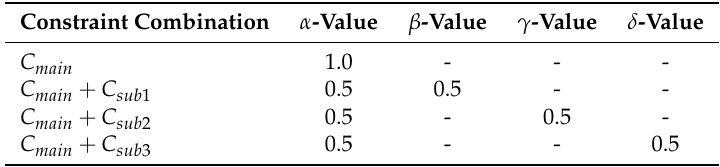
Table 4. Weights in models of various combinations of